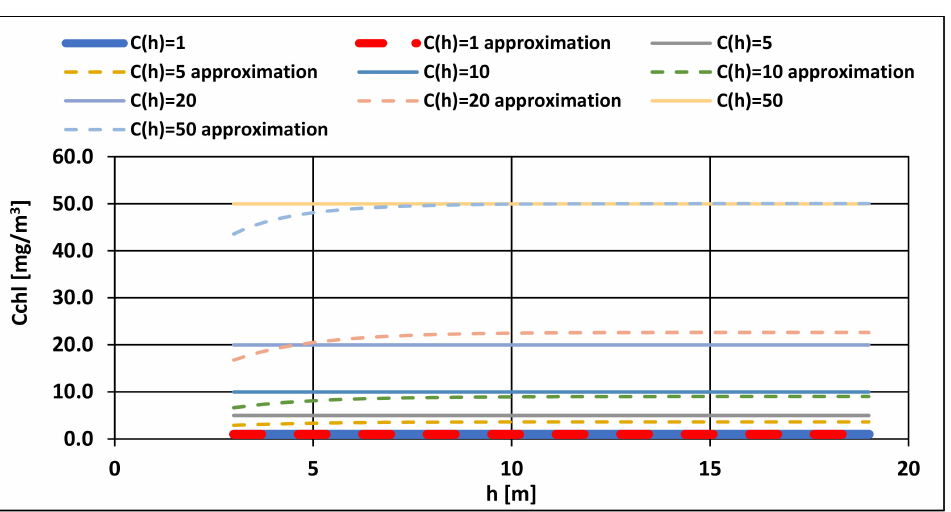
Figure 13. Chlorophyll a C chl concentrations as a function of depth h for Equations (7)–(9) and model (15)